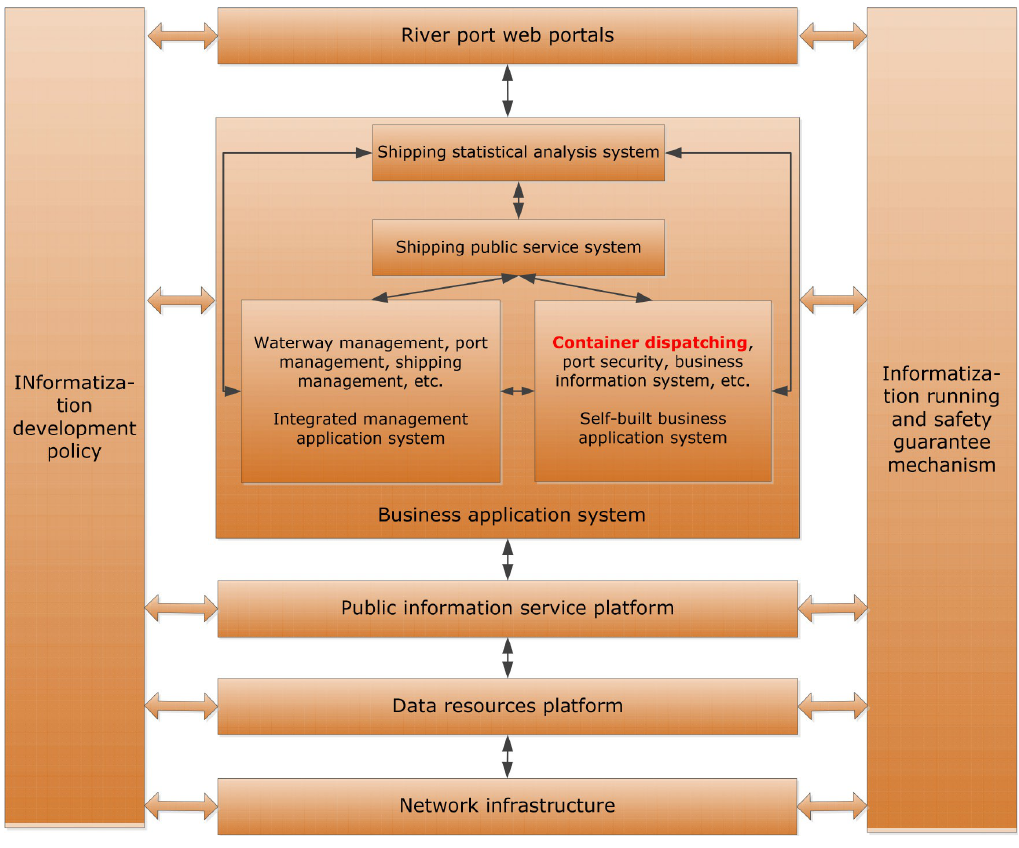
Figure 1. Informatization framework for river